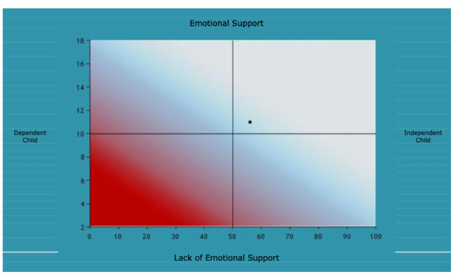
Figure A8. Joanna and Mr.